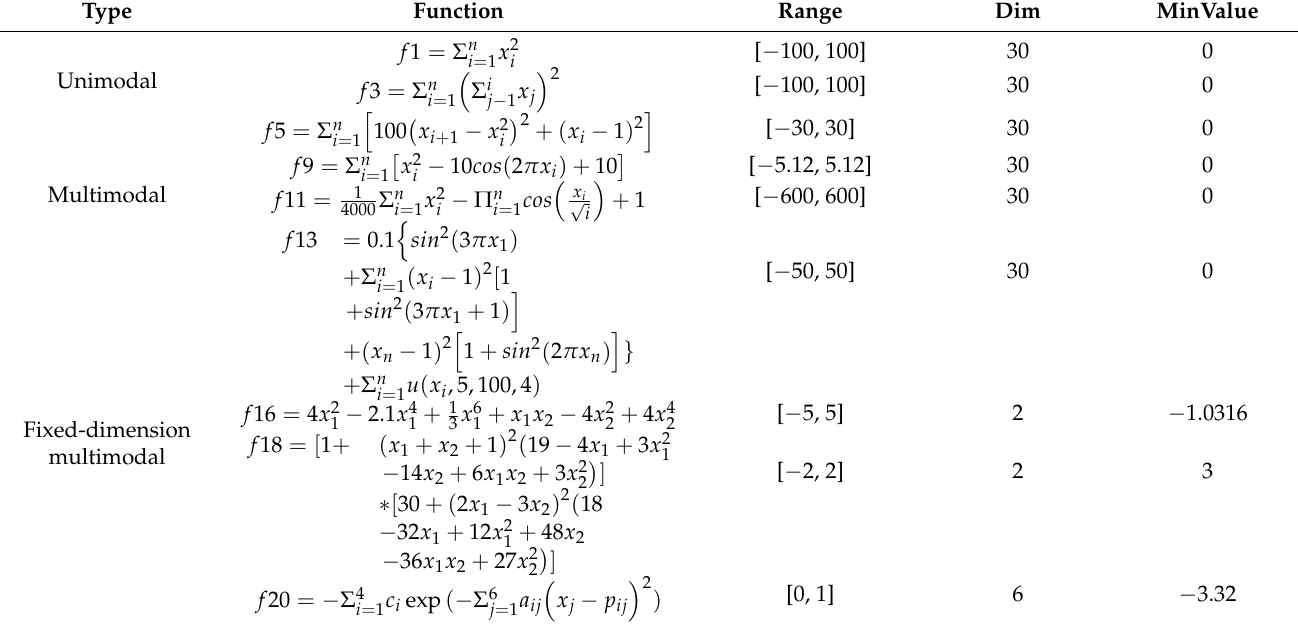
Table 2. Benchmark Functions.